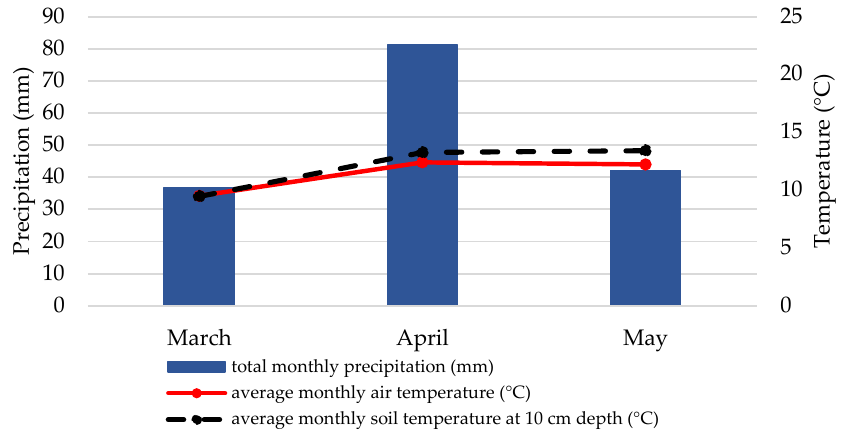
Figure 2. Weather conditions (the average monthly air temperature, total monthly precipitation and average monthly soil temperature at 10 cm depth) in March, April and May 2019, Zagreb. Data are presented up to 10 May 2019.